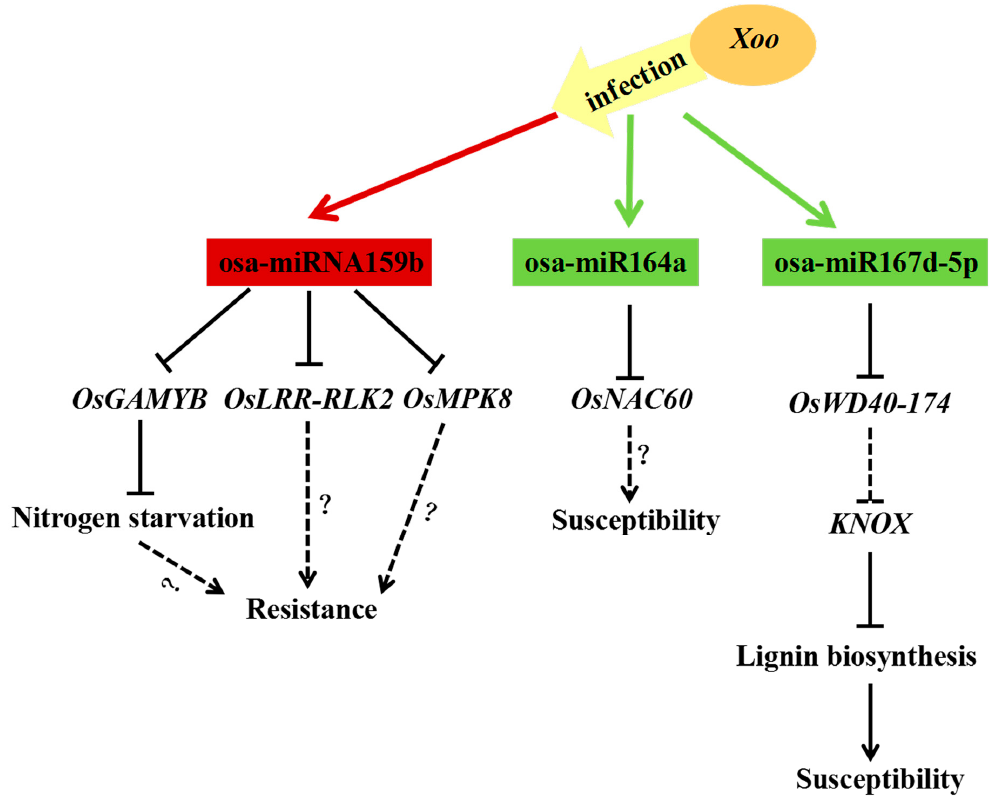
Figure 8. The potential work model of osa-miR159b, osa-miR164a and osa-miR167d-5p mediated immunity pathways upon Xoo infection. The up-regulated and down-regulated miRNAs are shown in red and green, respectively. Solid lines and dashed lines separately represent confirmative and putative regulatory links in rice or Arabidopsis